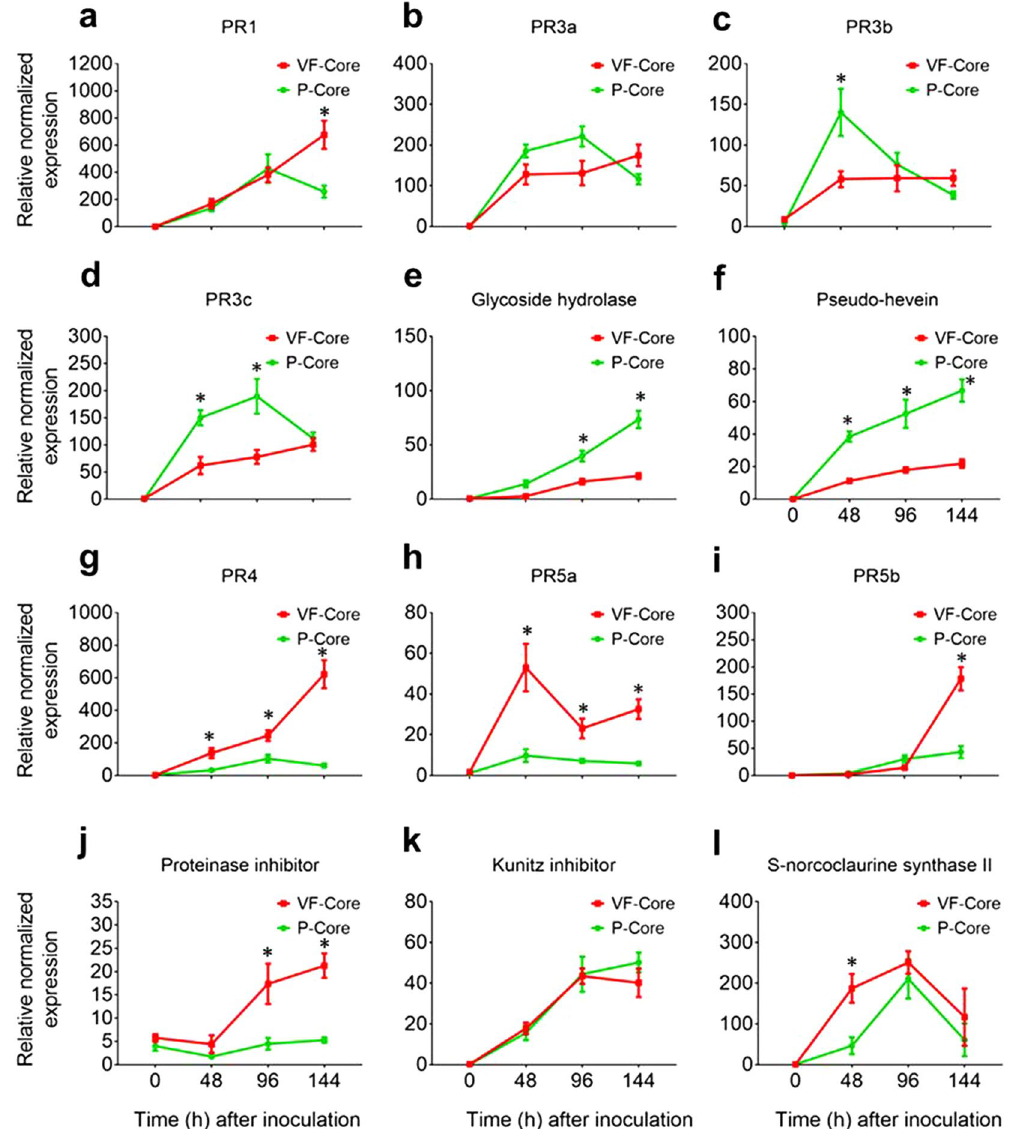
Figure 2. Expression of disease-responsive genes in the inoculated core tissues of ‘Valley Forge’ and ‘Princeton’. ( a – l ) Expression of different classes of disease responsive genes was investigated in the mock-inoculated (0 hpi) and inoculated core tissues of ‘Valley Forge’ (VF) and ‘Princeton’ (P). The expression of each gene was normalized to that of three elm reference genes ( EIF 5a , vacuolar ATP synthase and splicing factor 3B ) and was calculated relative to the control sample (P-bark at 0 hpi). The results are the mean ± SE of three biological replicates. Values marked with an asterisk ( * ) are significantly greater ( ≥ 2 times) than the control sample and the corresponding time point in the other genotype ( P <